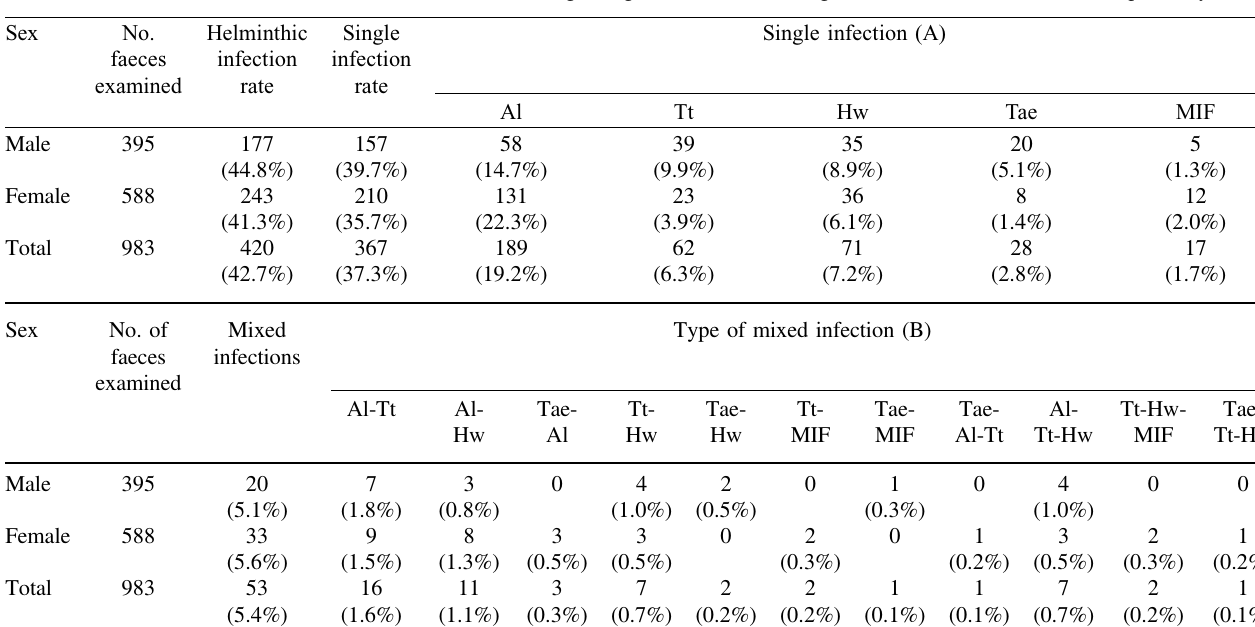
Table 1. Prevalence of helminths in males and females among villagers. A and B are single and mixed infection cases,